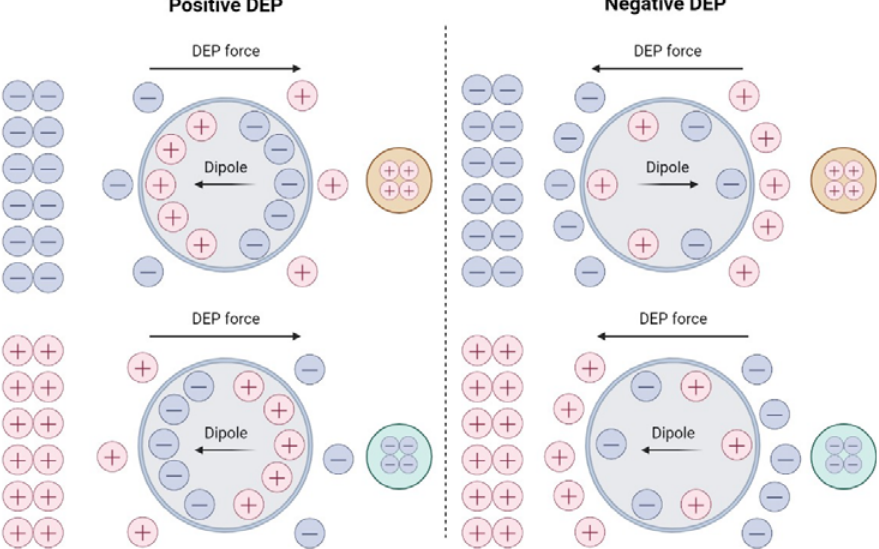
Figure 1. Polarization induced net dipole and dielectrophoretic force direction for a particle that is ( left ) more polarizable than the surrounding medium and ( right ) less polarizable. Top and bottom are two opposite arrangements of the background electric field.